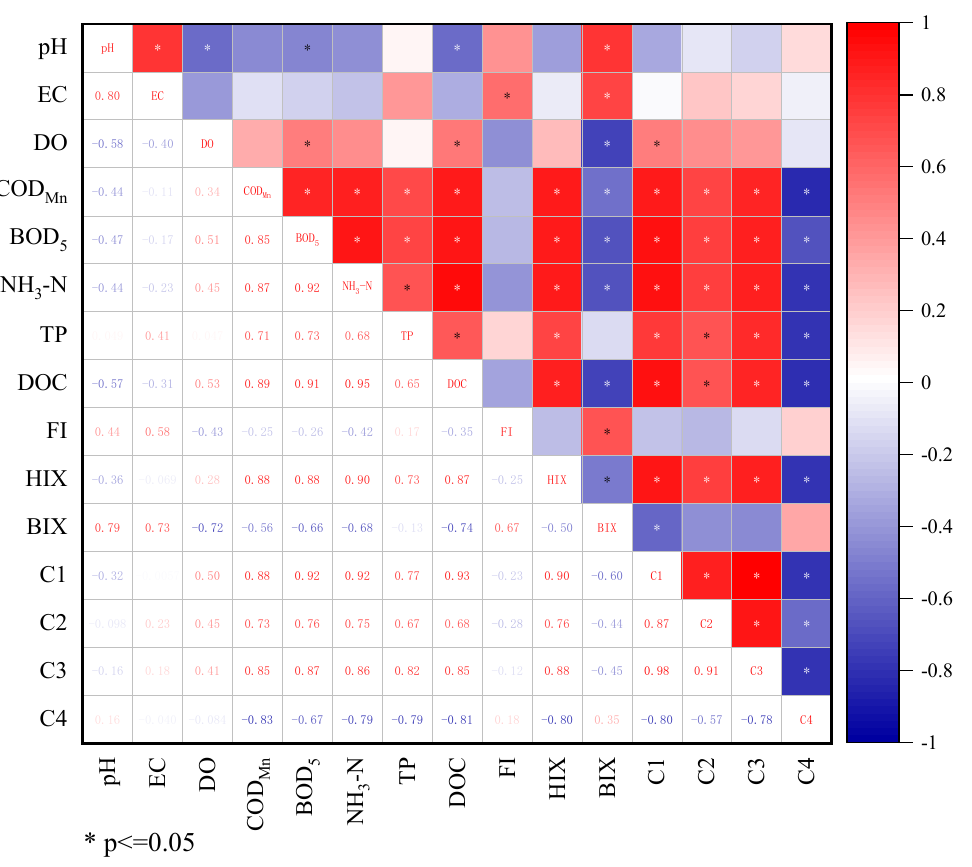
Figure 9. Correlation coefficient matrix between selected parameters.